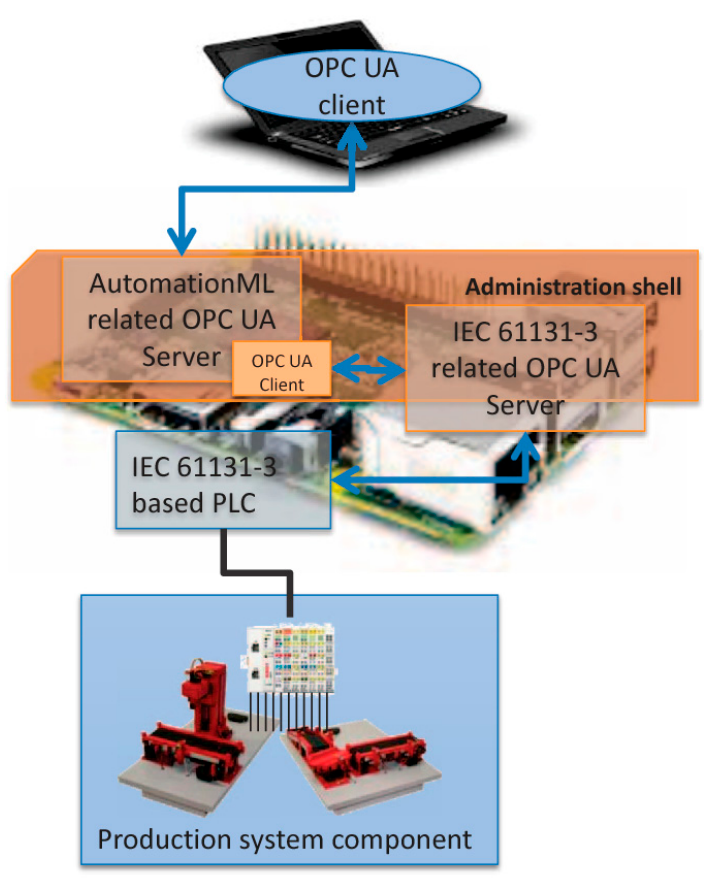
Figure 6. AutomationML implementation (Reprint from Reference [55]).